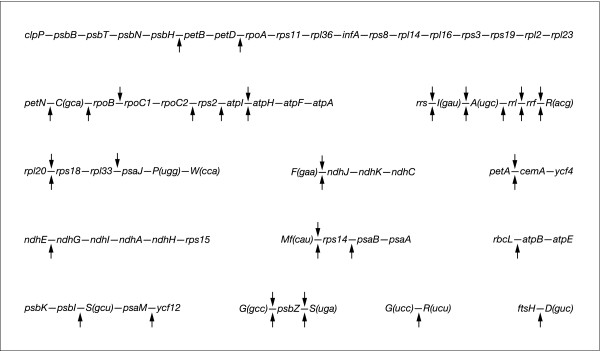
Fragmentation of ancestral chloroplast gene clusters during the evolution of the Zygnematales. The ancestral clusters shown are found in both Mesostigma [GenBank:NC_002186] and Marchantia [GenBank:NC_001319] cpDNAs. The top and bottom arrows denote the sites where they are broken in Staurastrum and Zygnema cpDNAs, respectively. For the polarities of the genes relative to one another, the reader should consult the gene map of Mesostigma cpDNA [11].